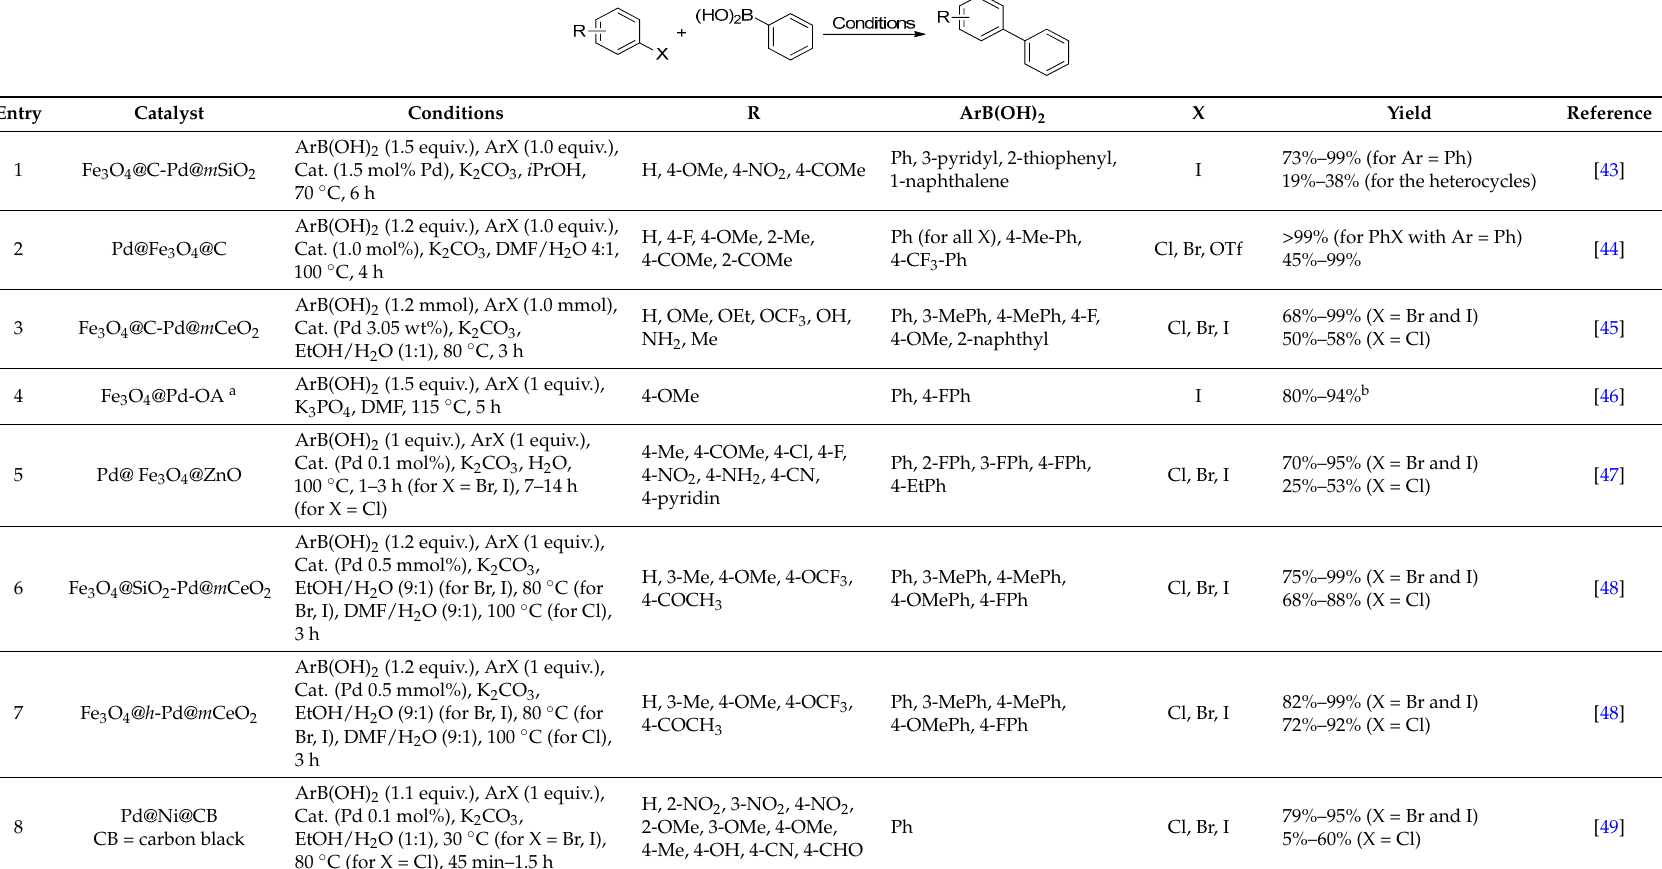
Table 1. Use of palladium directly deposited onto iron oxide nanoparticles as a catalyst for Suzuki–Miyaura cross-coupling.